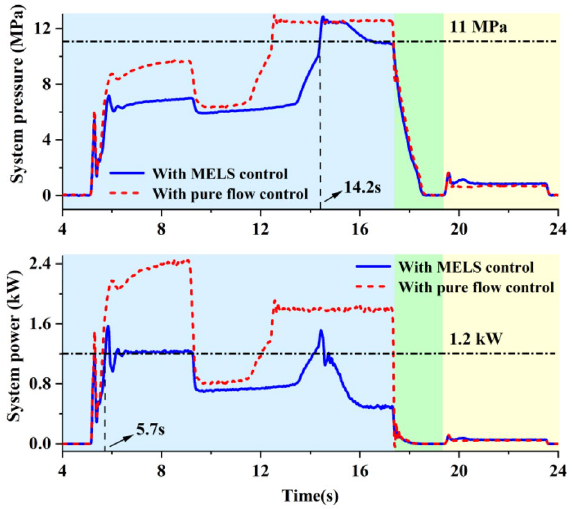
Figure 12 System pressure and power consumption